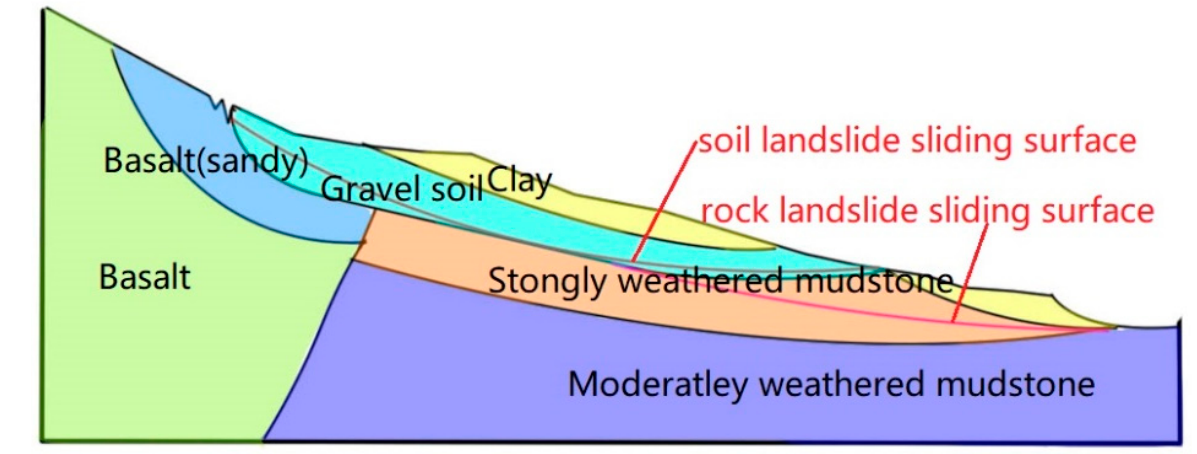
Figure 19. Geological character profile of Fangshan landslide.